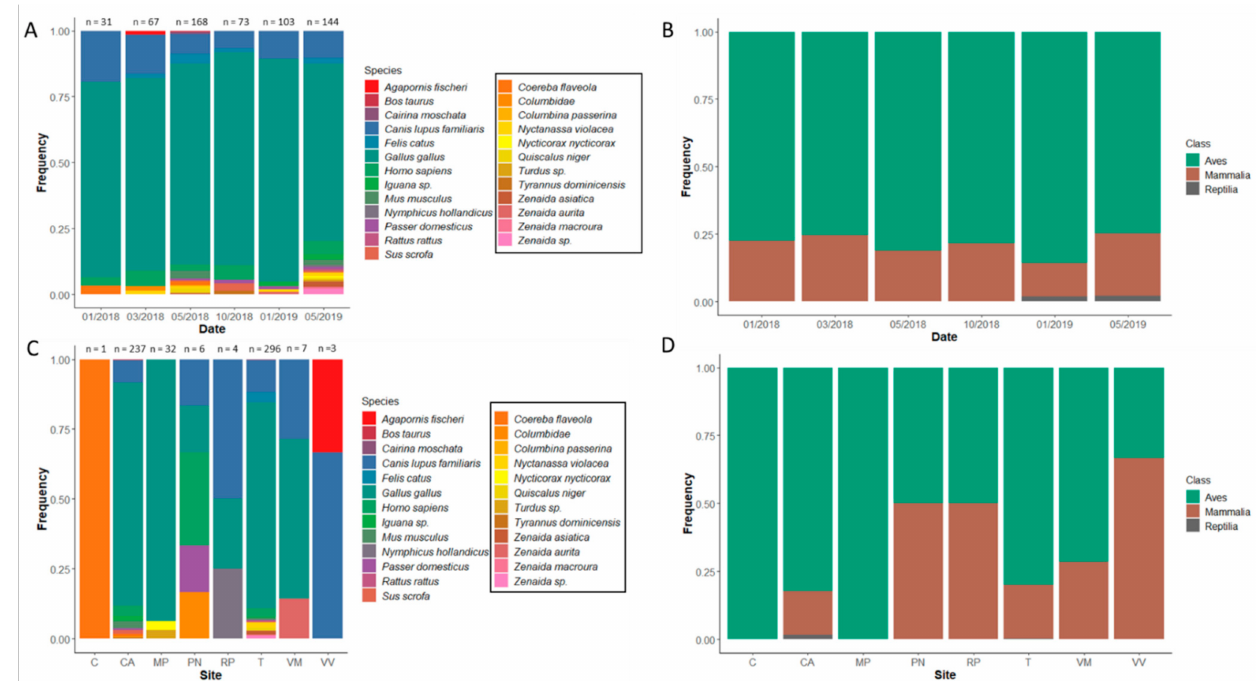
Figure 3. Barplots of taxonomic identification of DNA sequences from Culex quinquefasciatus collected in the San Juan Metropolitan Area, Puerto Rico. Plots ( A ) and ( B ) are divided by trapping date. Plots ( C ) and ( D ) are divided by trapping site. The x-axis provides either the trapping date or trapping site, and the y-axis is the frequency of taxon detection. The colors within the plot represent different vertebrate species (plots ( A ) and ( C )) or vertebrate classes (plots ( B ) and ( D )). Sample sizes per division are provided above the bars in plots ( A ) and ( C ). The black squares around the taxa in the legends in plots ( A ) and ( C ) are native wildlife, while the non-enclosed taxa are human